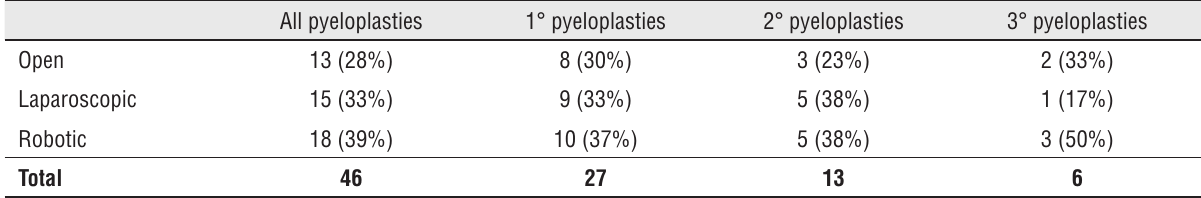
Supplementary Table S1 - Pyeloplasty operative approach.